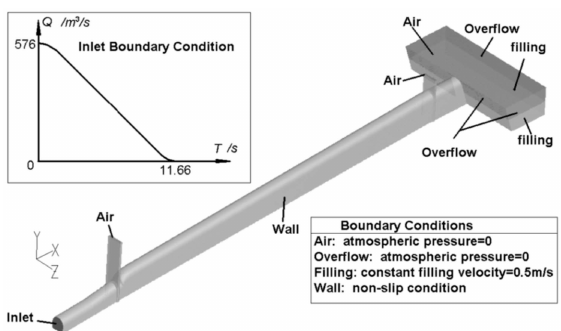
Figure 11. Schematic diagram of the domain and boundary conditions of the computational fluid dynamics (CFD)–volume of fluid (VOF) simulation [30].